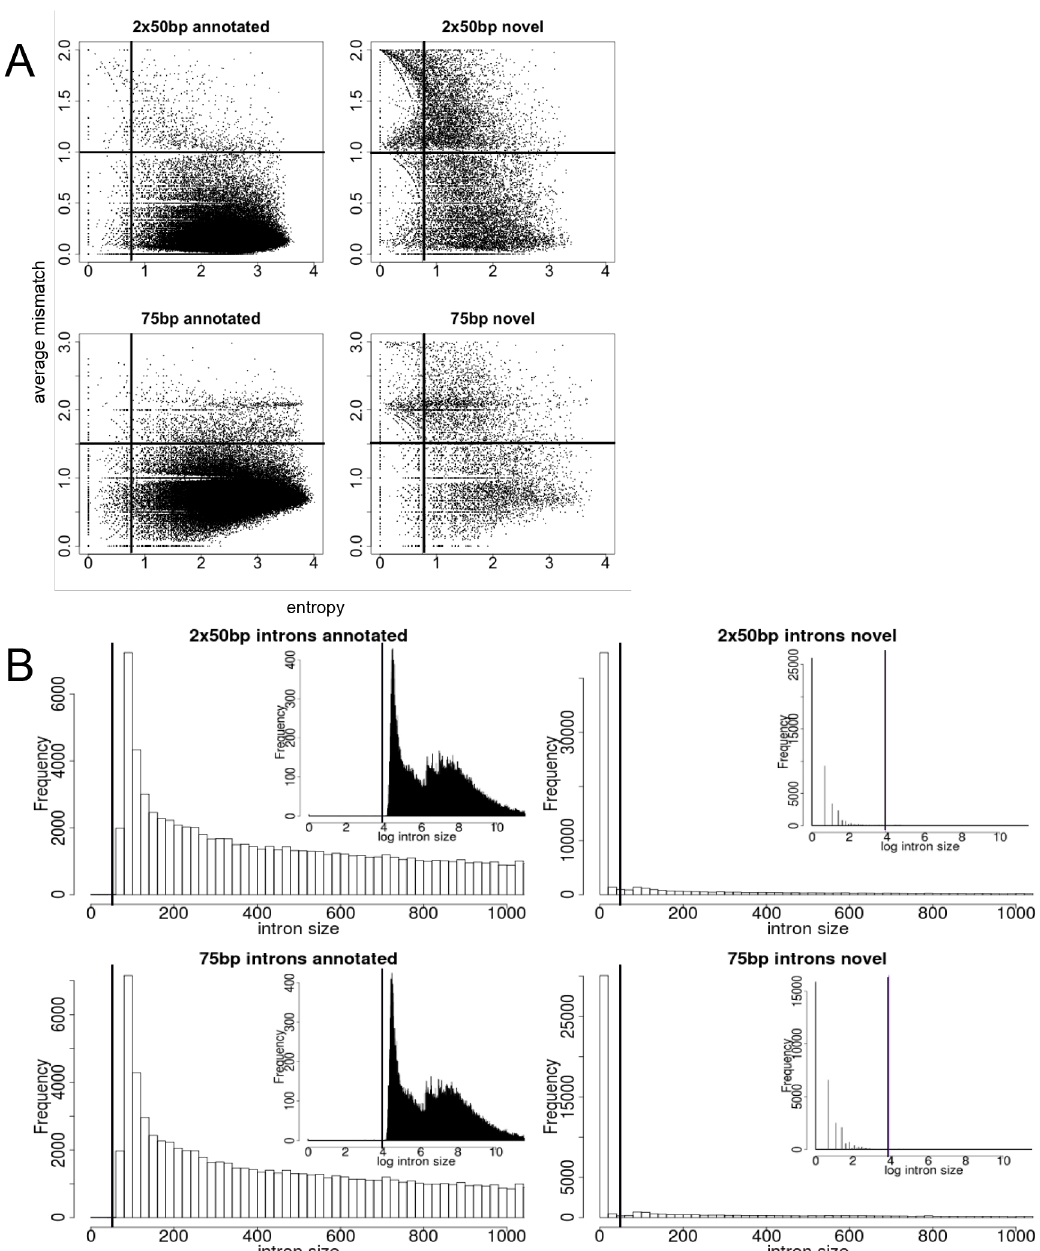
Fig 1. Plots for filtering splice junctions. (A) An example, from heart, plotting entropy versus average mismatches for annotated and novel splice junctions. Selected thresholds (0.75 entropy and 1.5 or 1 average mismatches, paired and single-end, respectively) are indicated by the dark lines and the lower right quadrants retained for further splice junction analyses. (B) Plots are for annotated only and novel splice junctions across all tissues for both paired-end and single end data. A vertical dark line indicates the applied threshold of 50 nucleotides. The main graphs are zoomed in to < 1000bp intron sizes, while the sub- graphs show all natural log scaled intron